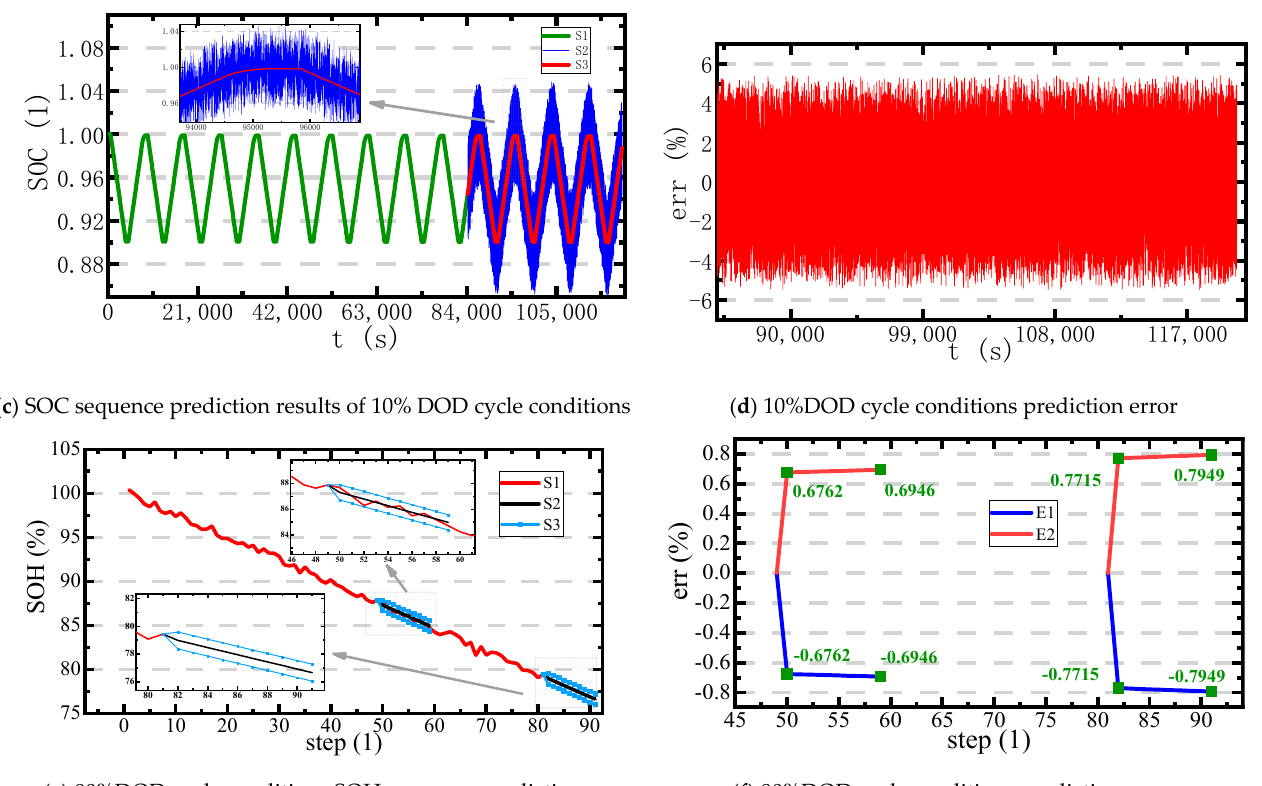
Figure 9. Model prediction effect.